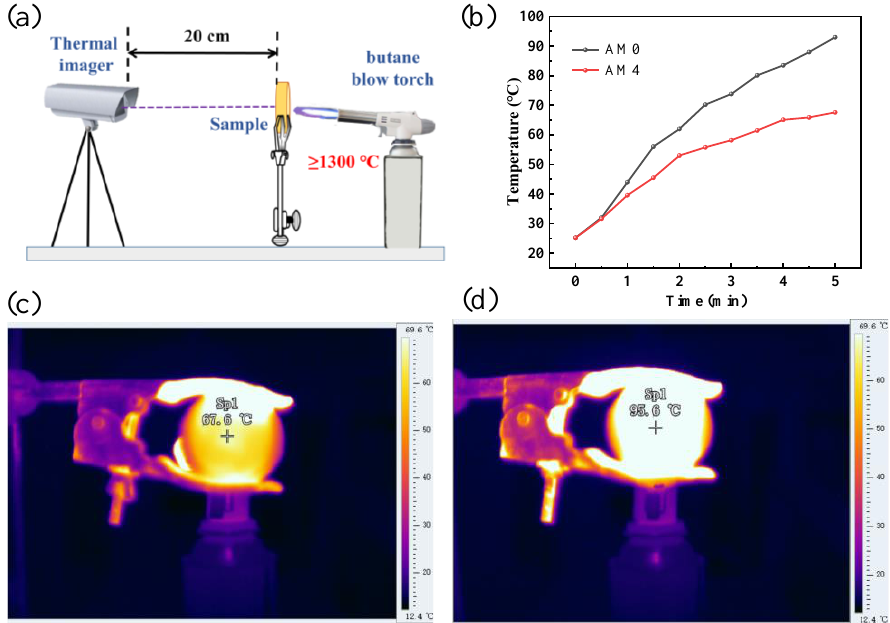
Figure 6. Schematic diagram of the high-temperature thermal insulation test ( a ); rear-surface temperature of AM0 and AM4 as a function of the burning time ( b ); pseudo-color thermal images of the samples after burning for 5 min: ( c ) AM4, ( d ) AM0.